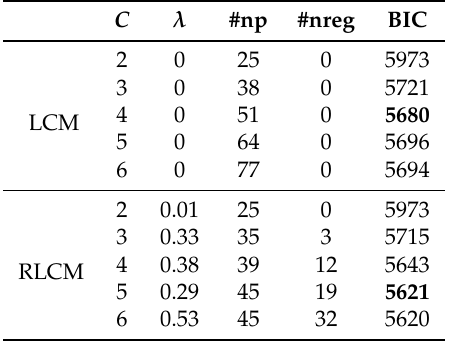
Table 10. SPM-LS dichotomous data: model comparison for exploratory LCMs and RLCM.